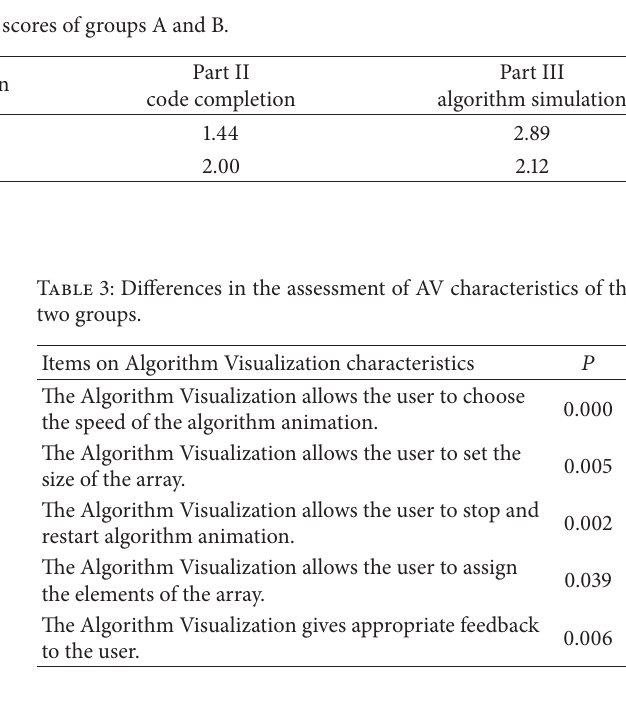
Table 4: Alpha values of the evaluation questionnaire